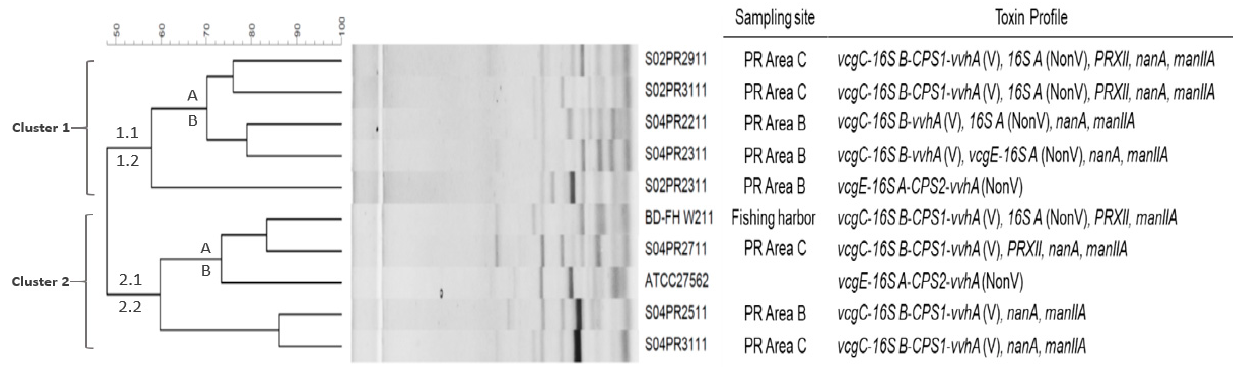
Figure 1. Genetic diversity of Vibrio vulnificus isolates by ERIC-PCR, combined with toxigenic profiling.